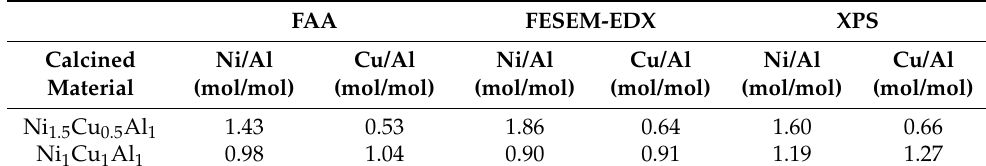
Table 2. Metal atomic ratios in materials calcined at 673 K for 4 h, measured by FAA, FESEM-EDX and XPS.